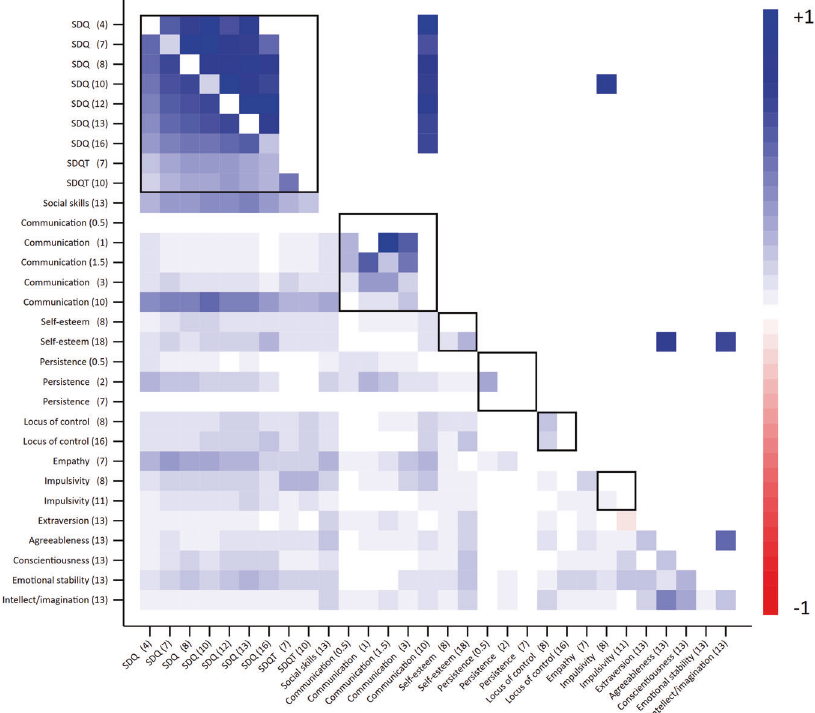
Fig. 1 Heritability, phenotypic correlations and genetic correlations of noncognitive skills. Age (years) in parentheses. Values on the diagonal represent heritability; values below the diagonals represent phenotypic correlations; values above the diagonal represent genetic correlations. Multiple testing was handled using a False Discovery Rate threshold of 5%. Empty cells display correlations that fell below the False Discovery Rate threshold. Black outline boxes indicate the same skills measured at different occasions. SDQ: parent reported strengths and dif fi culties questionnaire; SDQT: teacher reported strengths and dif fi culties questionnaire. See Supplementary Tables 2 and 3 for full